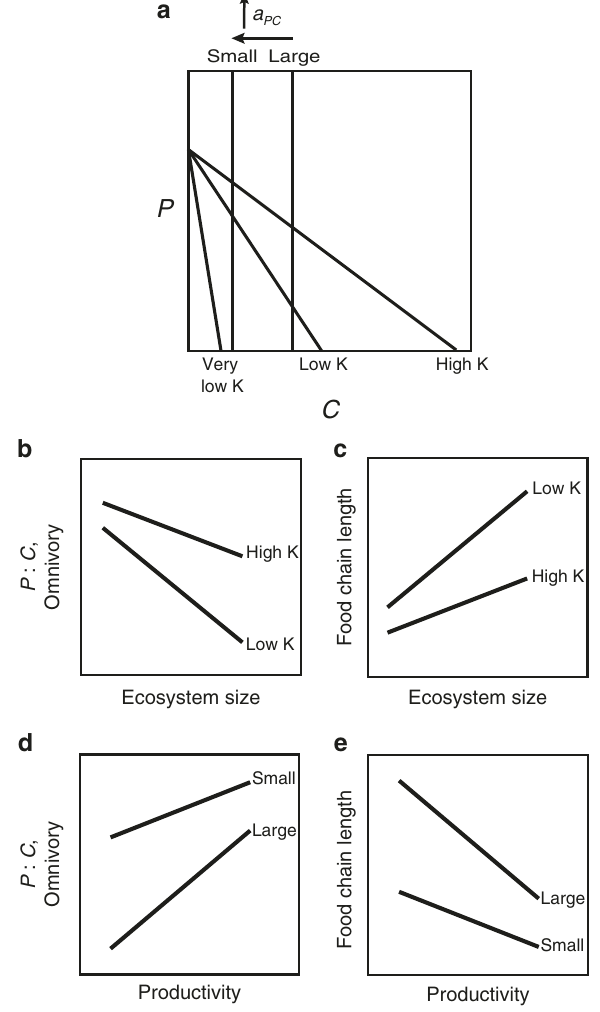
Fig. 2 Predicting context-dependency in environmental drivers of food- chain length. The simultaneous effects of increasing ecosystem productivity (i.e., increasing K ) and decreasing ecosystem size (i.e., increasing a PC ) on biomass pyramid shape, omnivory, and food-chain length. a Isoclines of a 2-level Lotka – Volterra model demonstrate equilibrium predator and consumer biomass under simultaneous changes in ecosystem productivity and size. At very low productivity only the consumer is present. b , c show the effect of ecosystem size, at various levels of productivity, on the degree of top-heaviness (i.e., the ratio of equilibrium predator and consumer biomass), resultant omnivory, and consequent food chain length. d , e show the same for the effect of productivity at various levels of ecosystem size. As demonstrated in Fig. 1b, top-heavy food webs (i.e., with elevated predator: consumer biomass ratios) promote greater omnivory.